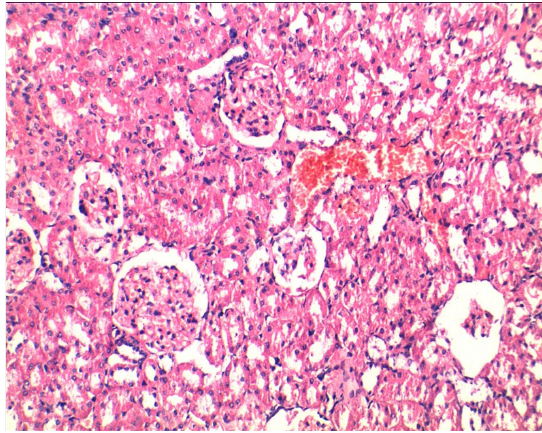
Fig. 1. Part in the cortex of the kidneys animals after 14 after in experimental skin burn injury of use HAES-LX-5